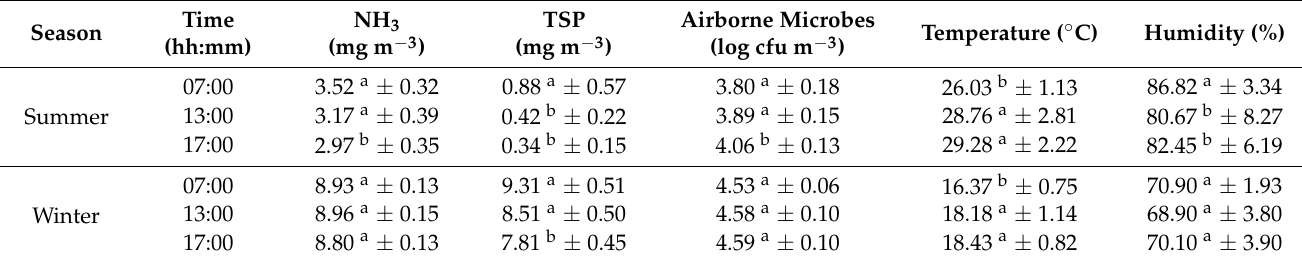
Table 3. Summary of measurements at different sampling times during summer and winter